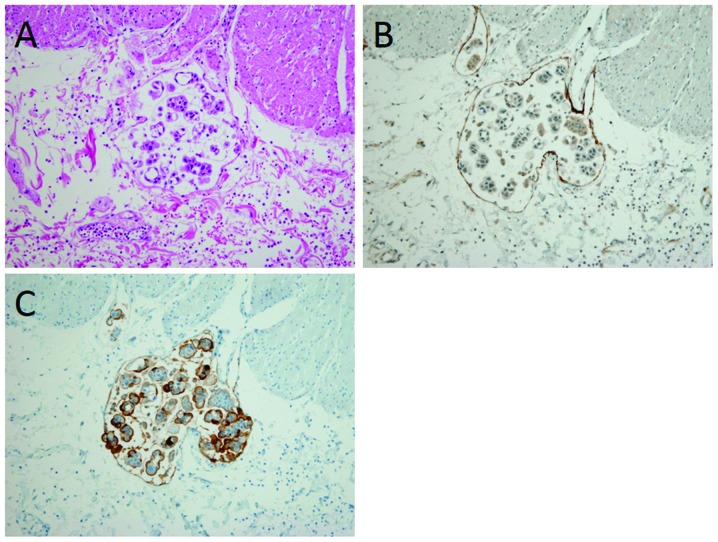
Marked lymphatic invasion of IMPC component was detected (A, top left), immunohistochemical staining for D2-40 revealed the endothelial lining cells (B, top right). Immunohistochemical staining for MUC1 revealed the ‘inside-out’ pattern (C, bottom left). IMPC, invasive micropapillary carcinoma.